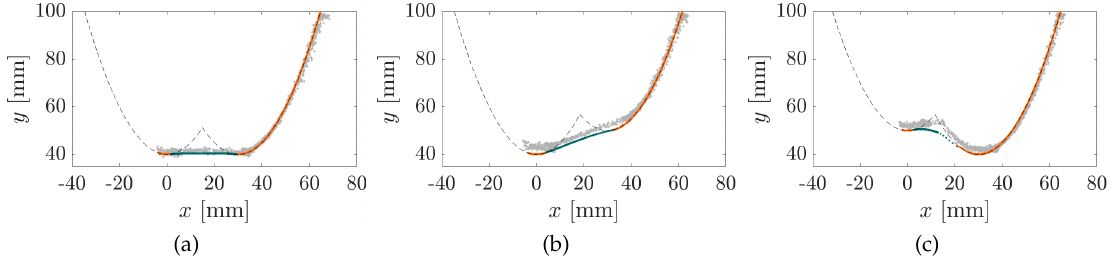
Figure 6. Contour reconstruction of objects O1 ( a ), O2 ( b ) and O3 ( c ) assuming SPC only: Contact points based on the simulated support reactions (SPC in orange and TPC in green) and the measured support reactions